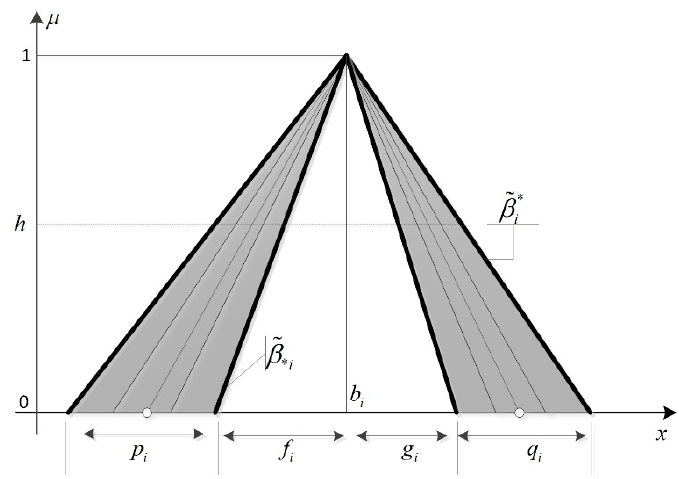
Figure 1. Representation of regression coefficients.